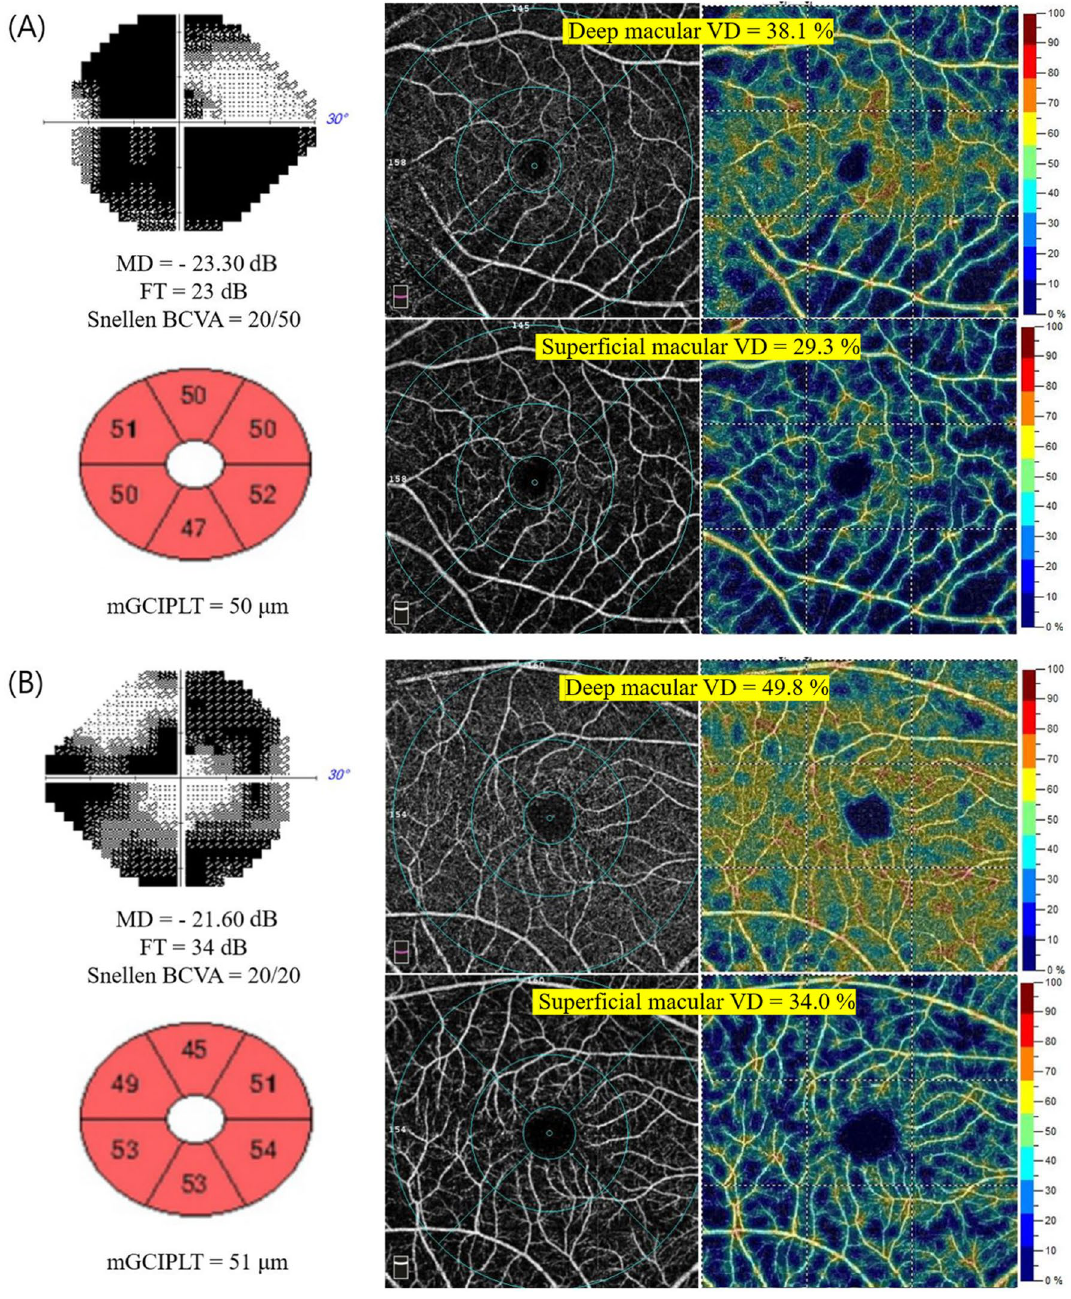
Figure 2. Two representative cases of advanced open-angle glaucoma with similar visual field (VF) mean deviation (MD) and macular ganglion cell-inner plexiform layer thickness (mGCIPLT) and different central visual function (CVF) parameters. ( A ) Advanced OAG case with CVF impairment. Optical coherence tomography angiography (OCT-A) en-face image (deep layer; top middle, superficial layer; bottom middle) and macular vessel density (mVD) map (deep layer; top right, superficial layer; bottom right) reveal that the deep and superficial layer mVDs are 38.1% and 29.3%, respectively. ( B ) Advanced OAG case with CVF preservation. OCT-A en-face image (deep layer; top middle, superficial layer; bottom middle) and mVD map (deep layer; top right, superficial layer; bottom right) demonstrate that the deep and superficial layer mVDs are 49.8% and 34.0%, respectively. Deep layer mVD loss is more pronounced (38.1% vs. 49.8%) in the eye with CVF impairment (FT = 23 dB, A ) than in the eye with CVF preservation (FT = 34 dB, B ) despite both cases having similar VF MD (− 23.30 dB vs. − 21.60 dB), mGCIPLT (50 μm vs. 51 μm), and superficial layer mVD (29.3% vs. 34.0%). These findings indicate that deep mVD correlates well with CVF parameter, such as FT, in eyes with advanced glaucoma. VF, visual field; CVF, central visual function; VD, vessel density; OCT-A, optical coherence tomography